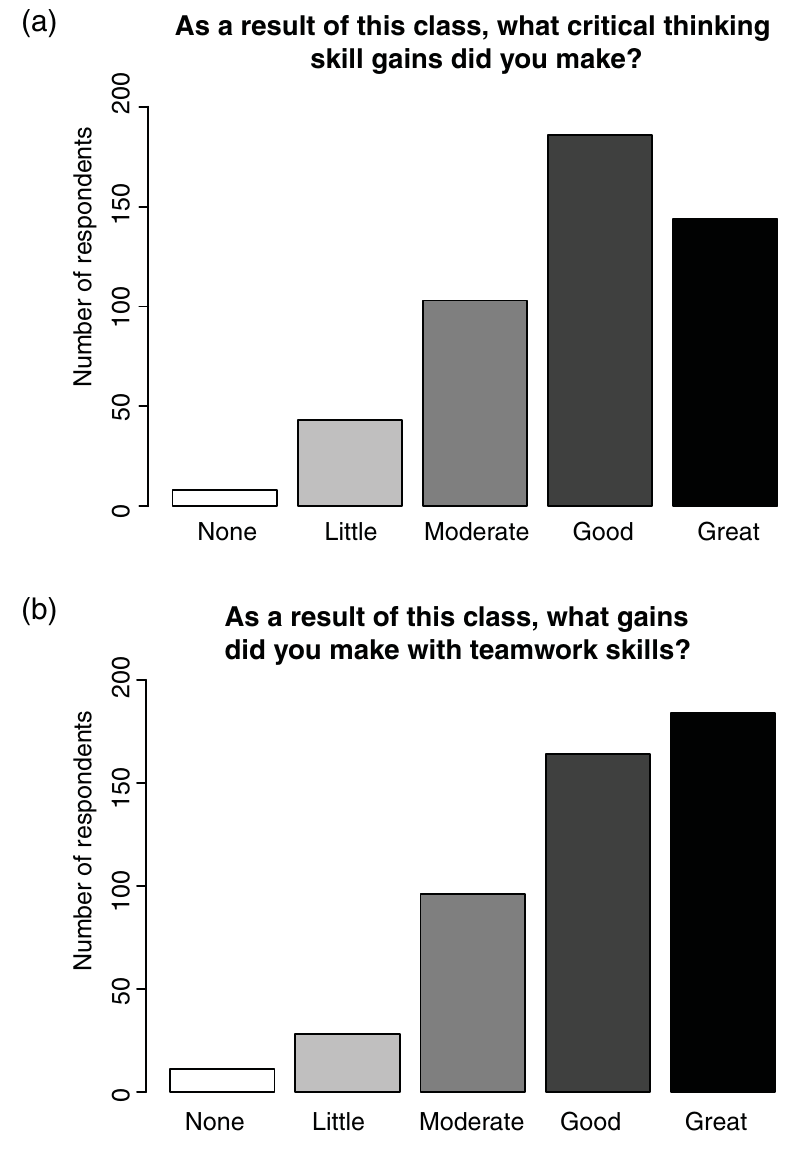
Fig 2. Student perception of learning gains. An overwhelming majority of students, compiled across all years of the study (2013–2016), ranked their gains as moderate or higher in teamwork (a) and critical thinking skills (b) as a result of the